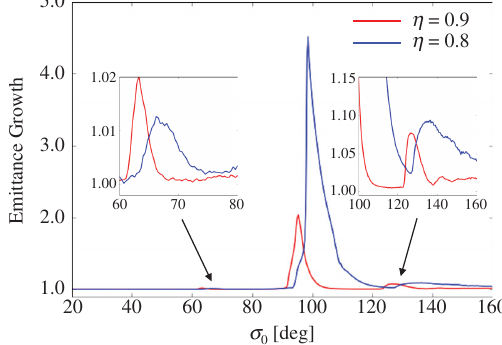
FIG. 5. W ARP simulation results in consideration of random nonlinear error fields. The initial conditions are equivalent to those in Fig. 2, except for the inclusion of random nonlinearities in quadrupole magnets to emulate the ordinary linear beam transport situation. The absolute strengths of high-order multi- pole components in each focusing element are defined by using uniform random numbers within the range from 0 to 2, such that their average values over 100 FODO cells (200 Q-magnets) agree with the strengths of the periodic nonlinearities assumed in Fig. 4 for the case of the rms misalignment of 0.05